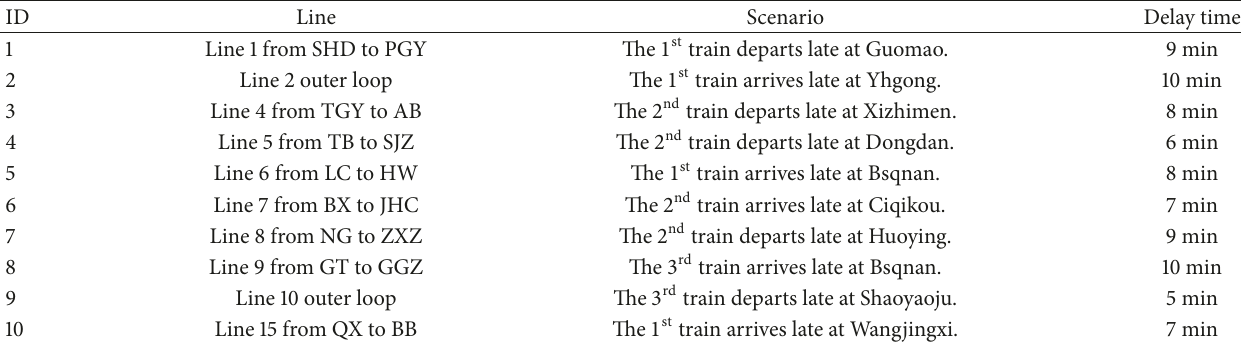
Table 2: Delay scenarios in detail.